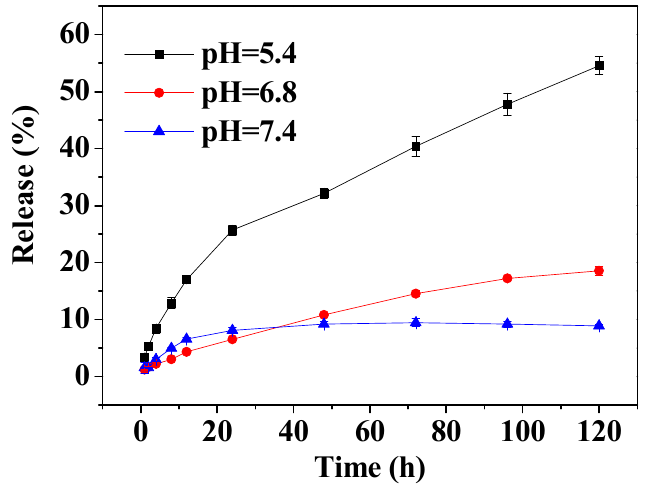
Figure 5. The release rate of curcumin loaded in MSN-PEI-FA at different pH values.